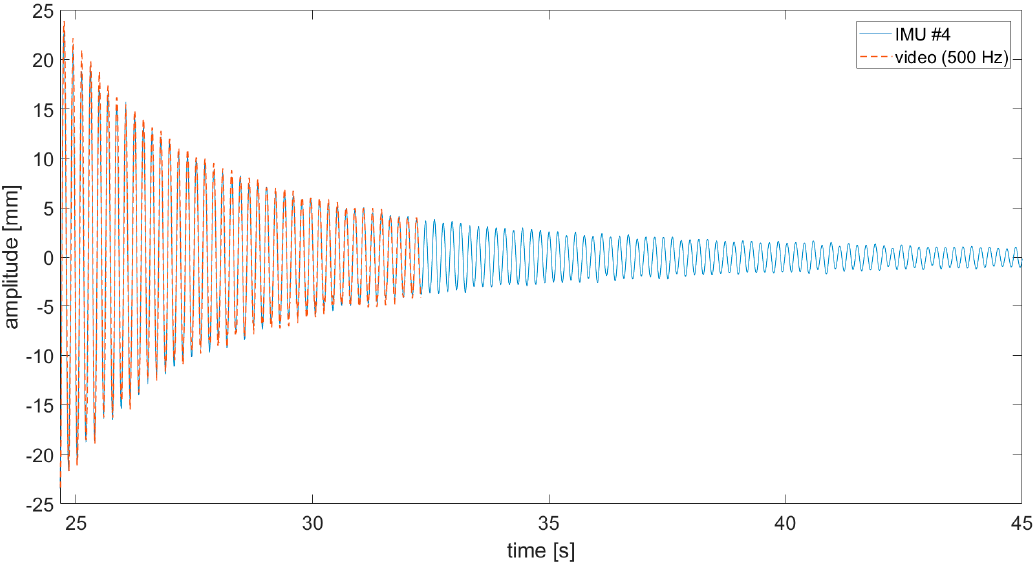
Figure 8. Comparison of displacement time histories (video vs. IMU #4 acquisition).